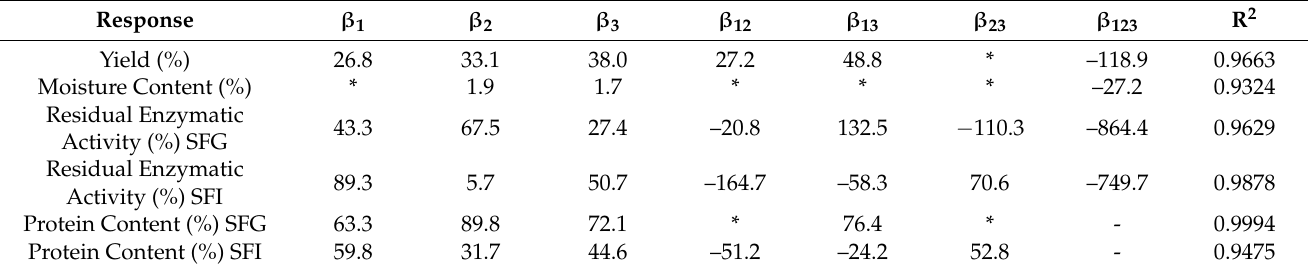
Table 4. Regression coefficients ( β 1, β 2, and β 3) and adjusted R2 of the produced models.